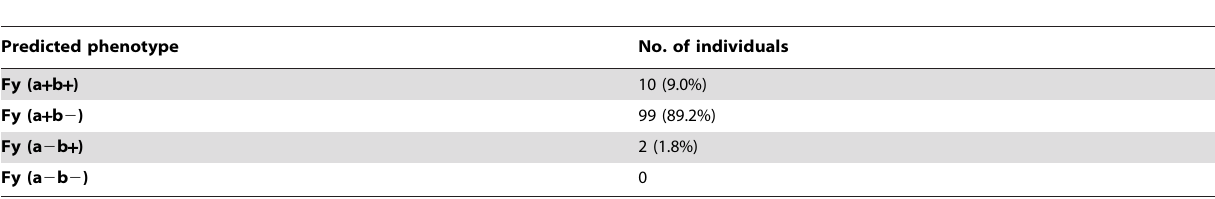
Table 1. Proportion of predicted phenotypes of blood donors and P. knowlesi infected patients.